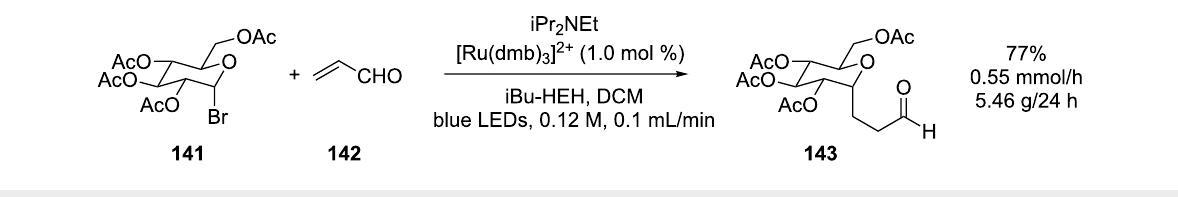
Scheme 49: Light-mediated conjugate addition of glycosyl bromide 141 to acrolein.